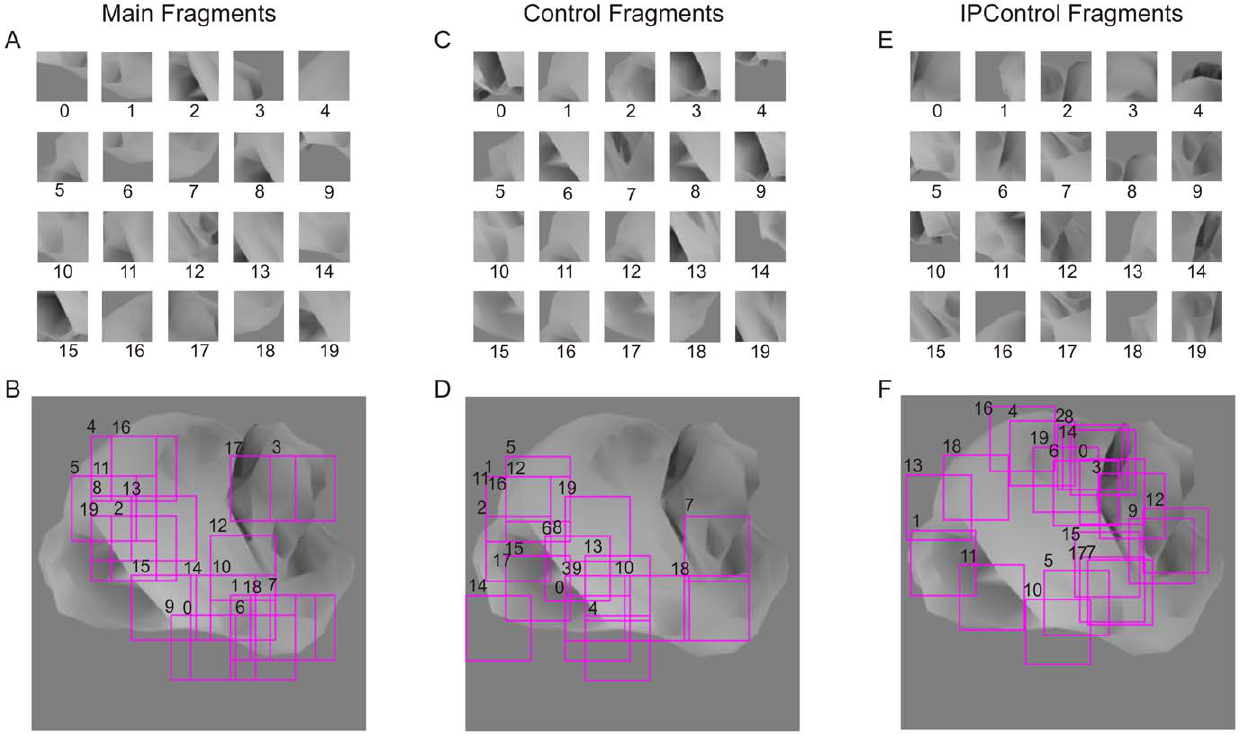
Figure 6. Object fragments used in Experiment 2. ( A ) Main fragments, which are 50 6 50 pixel fragments of objects from class Z that are useful for distinguishing class Z from class X ( i.e ., Main task in this experiment). ( B ) Location of the Main fragments, overlaid on a typical object from class Z. Fragment borders are outlined for clarity. ( C ) Control fragments, which are fragments of objects from class Z that are useful for distinguishing class Z from class Y (‘Control task’), but are not useful for the Main task. ( D ) Location of the Control fragments. See text for details. ( E ) IPControl fragments, which were uninformative for the Main task, but comparable visually to the Main fragments. ( F ) Location of the IPControl fragments. In panel B, D and F, the fragments are overlaid on a typical object from class Z. Note that the fragments were extracted from different images of class Z, although they are overlaid together in this figure. Thus, although some of the fragments overlap in this figure, they are usually quite different in their visual content.